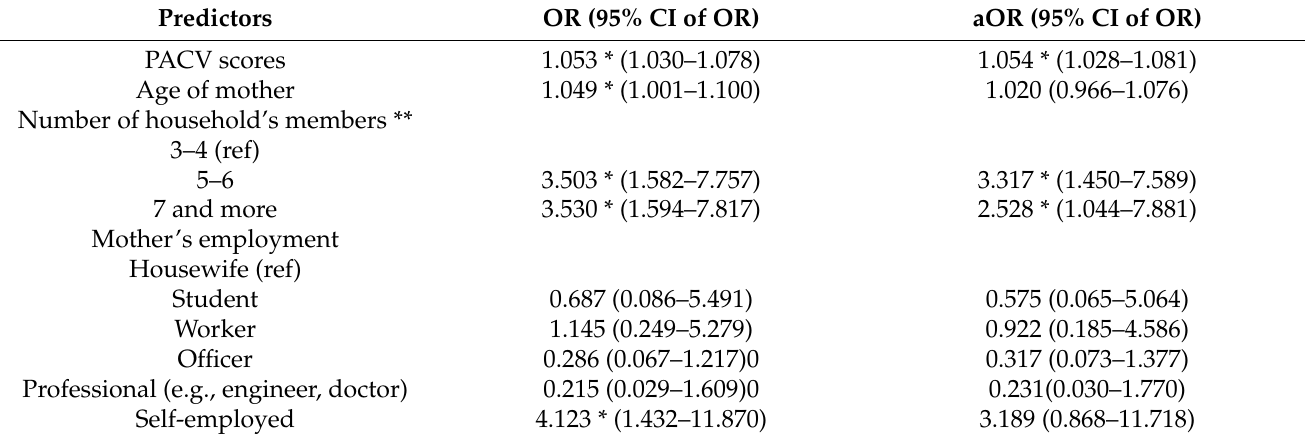
Table 3. Predictors of partial vaccination or no vaccination with measles vaccine in Khartoum state,